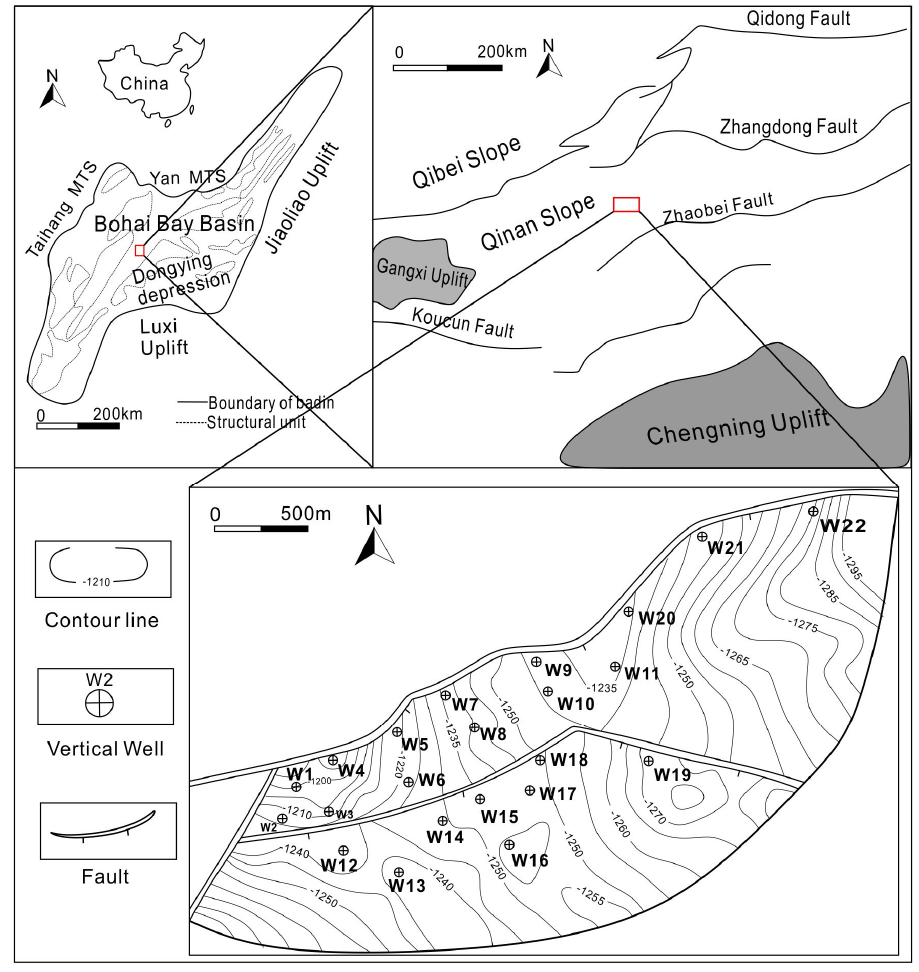
Figure 4. Location of studied area.